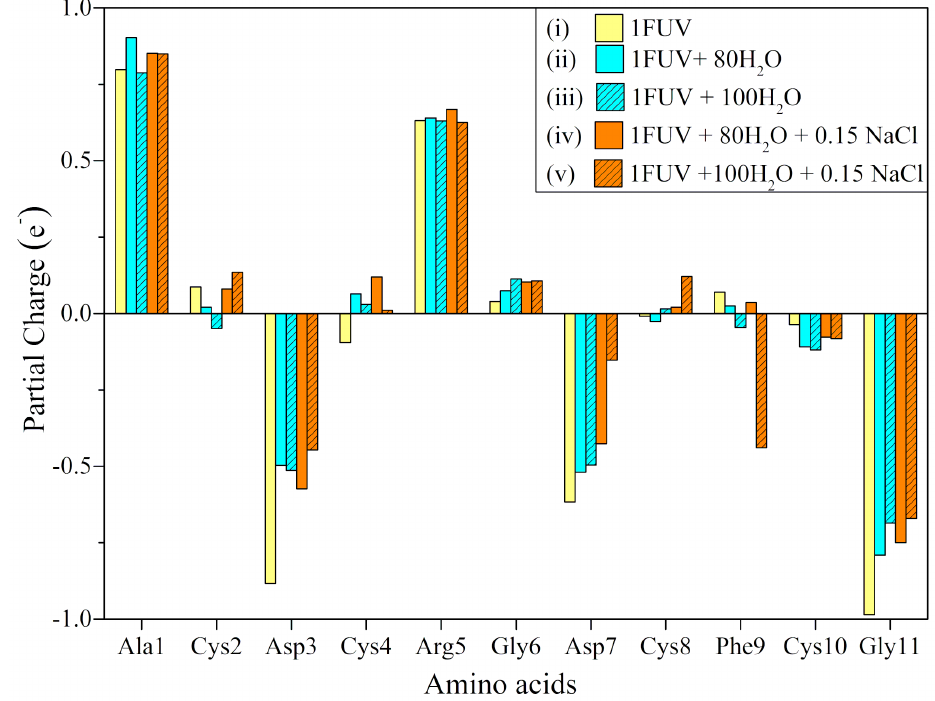
Figure 4. Partial charge (PC) distributions in terms of AAs for five 1FUV models ( i )–( v ) in various environments as shown in